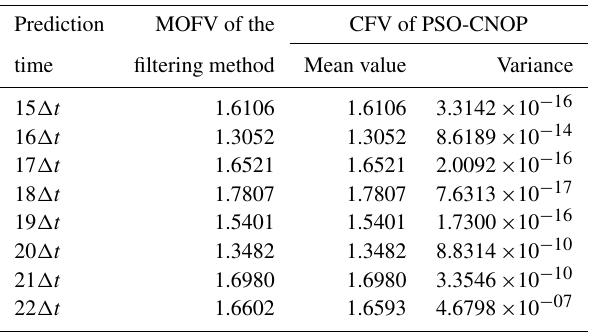
Table 3. The precision analysis of the CNOPs produced by PSO- CNOP at different forecast